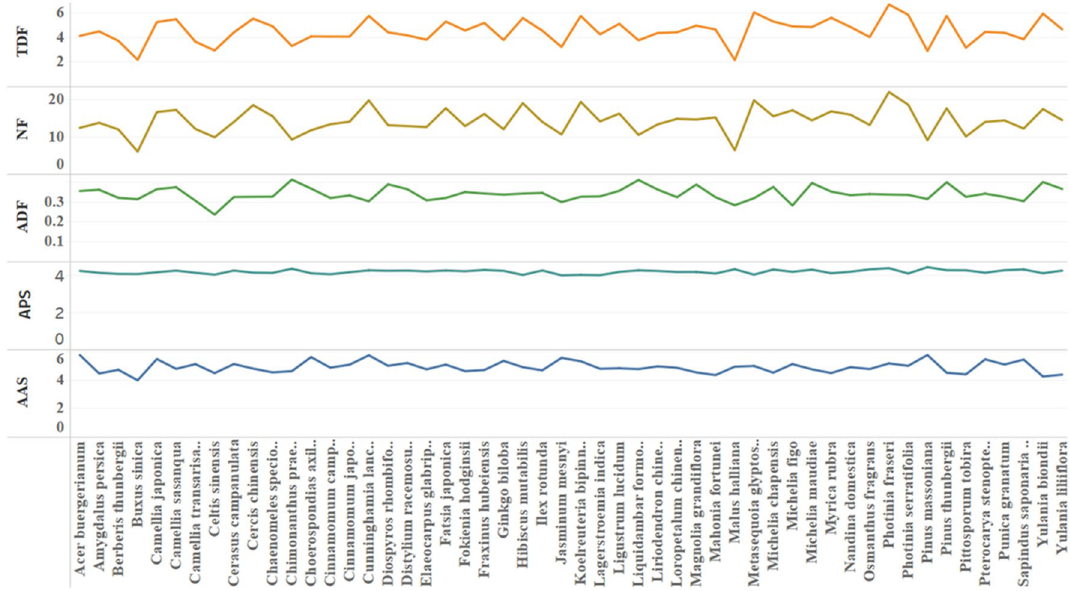
Figure 2. Statistical analysis of eye movement index means description of different species. Where TDF: Total duration of fixations; NF: Number of fixations; ADF: Average duration of fixations; APS: Average pupil size; AAS: Average amplitude of